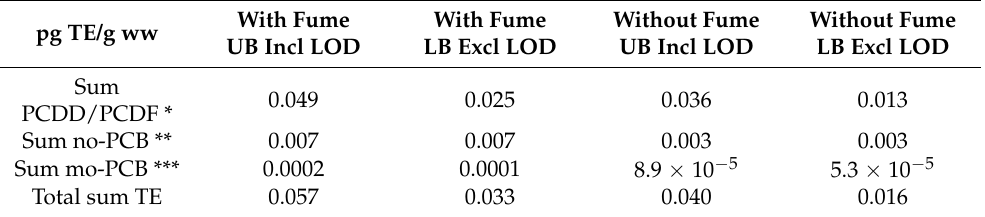
Table 10. Concentrations (pg TE/g ww) for dioxins and furans (PCDD/PCDF), non-ortho PCBs (no-PCBs) and mono-ortho PCBs (mo-PCBs) and sum of all three groups (Total sum TE), fermented with and without fume (n = 2). For upper bound (UB), <LOD concentrations are included; and <LOD concentrations are set to zero in lower bound (LB). With Fume With Fume Without Fume Without Fume pg TE/g ww UB Incl LOD LB Excl LOD UB Incl LOD LB Excl LOD